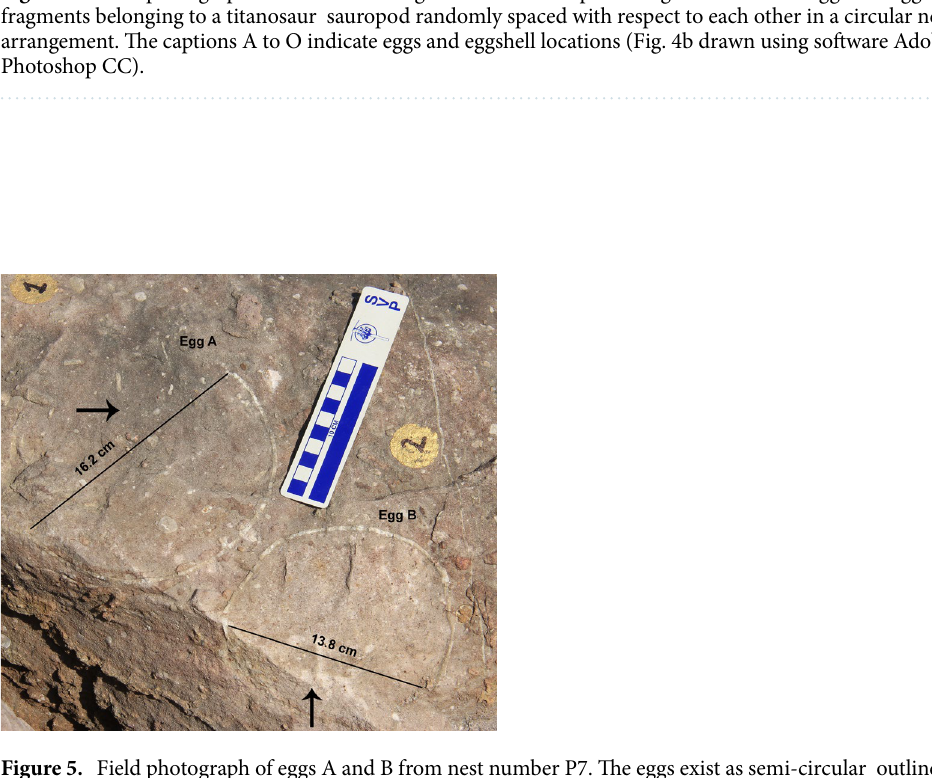
Figure 5. Field photograph of eggs A and B from nest number P7. The eggs exist as semi-circular outlines and the gaps (see arrows) possibly represent hatching